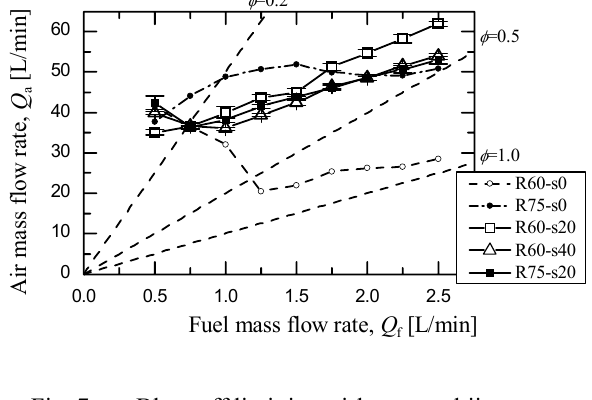
Blow-off limit in swirl-type multijet